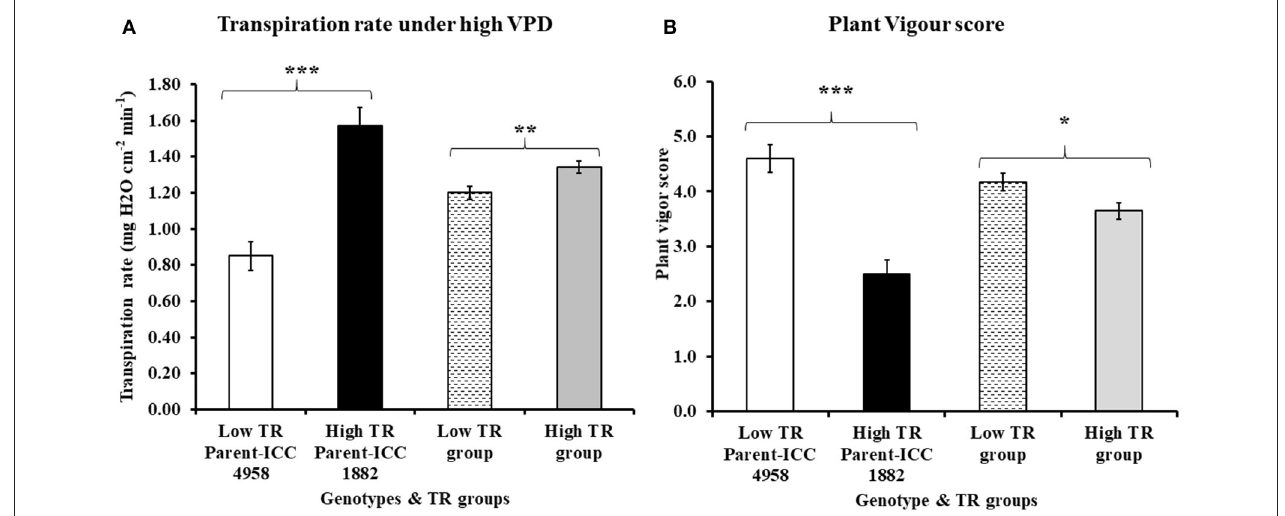
FIGURE 1 | Variation in (A) transpiration rate under high VPD and (B) plant vigor score in both parents and progenies (RIL) contrasting TR group. In both graph A and B, open bar represents low TR parent ICC 4958, closed bar represents high TR parent ICC 1882, bar filled with broken lines represents the low TR group and bar filled with gray color represents the high TR group. Each data point of TR and plant vigor represents the means ( ± SE) of 6 and 4 replication respectively. Bars with *, ** and *** (astric) symbols are significantly different from each other at P < 0.05, P < 0.01, and P < 0.001, respectively.